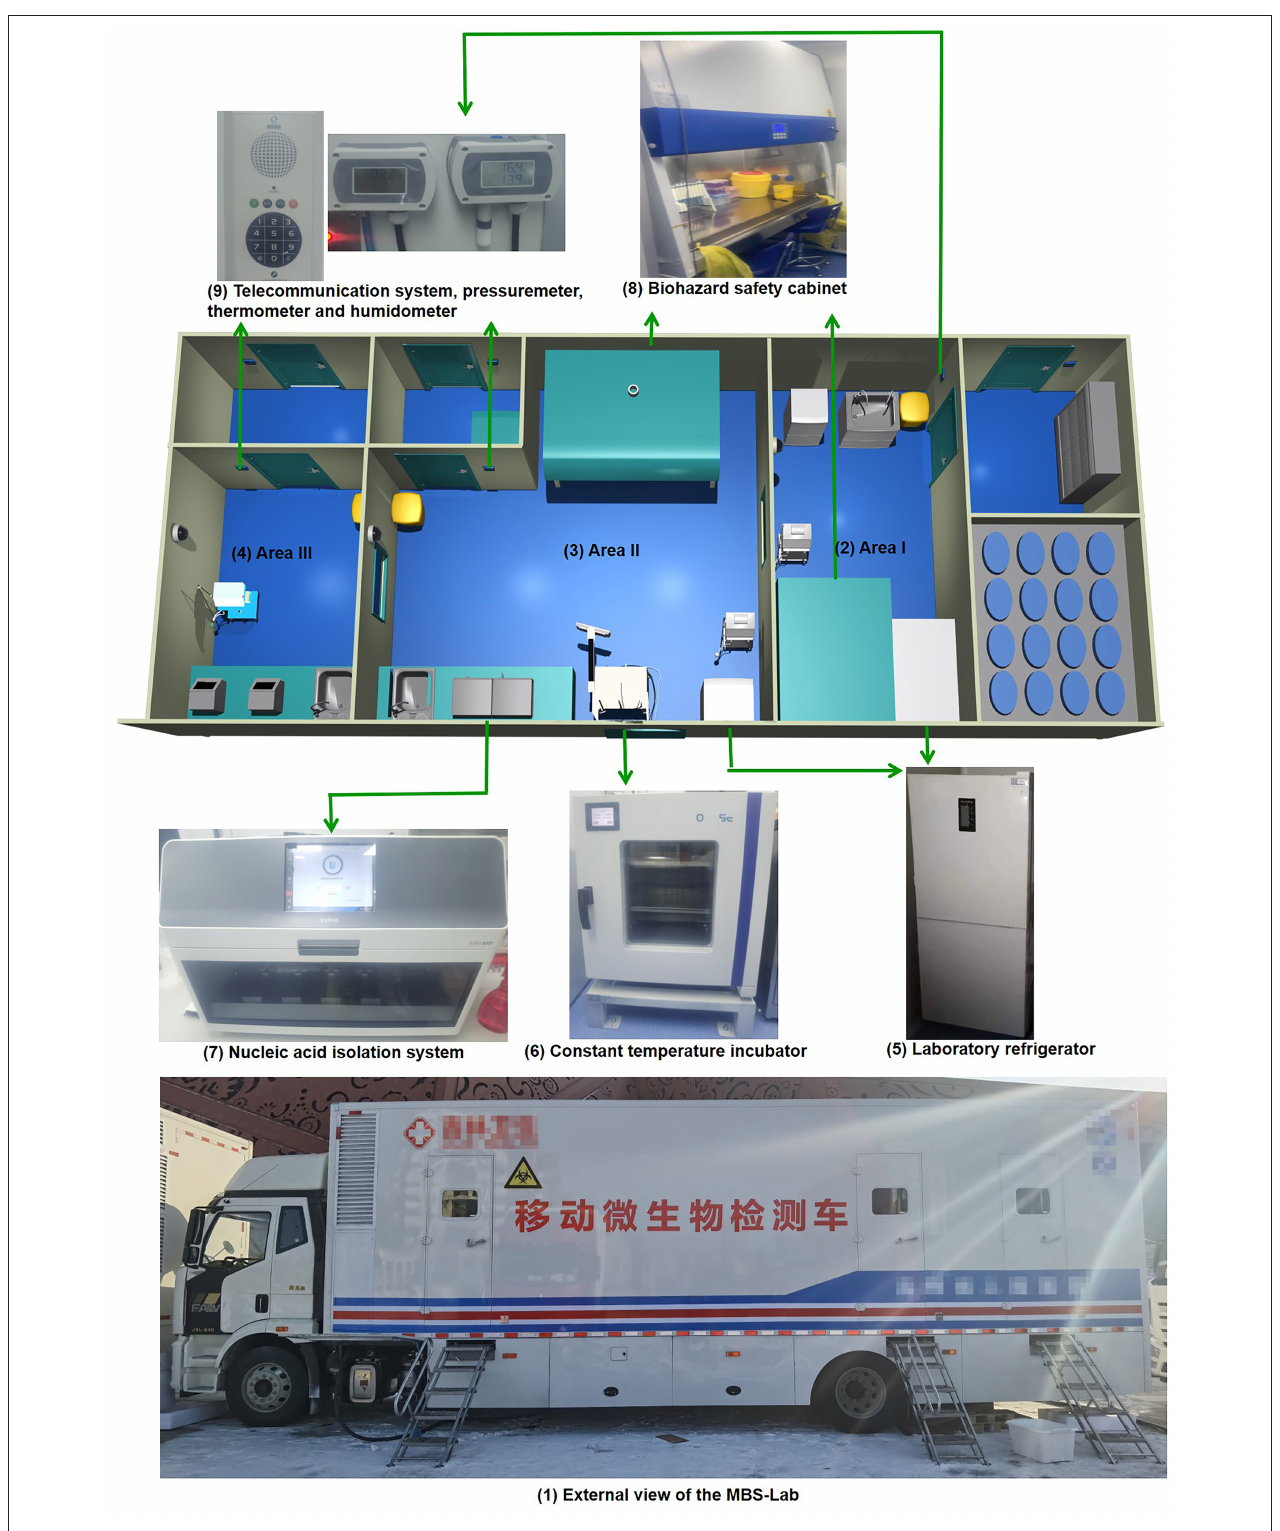
FIGURE 1 | Layout of main devices in the mobile biosafety laboratory. (1) External view; (2) area I; (3) area II; (4) area III; (5) laboratory refrigerator; (6) constant-temperature incubator; (7) nucleic acid-isolation system; (8) biohazard safety equipment; (9) telecommunication system, pressure meter, thermometer and